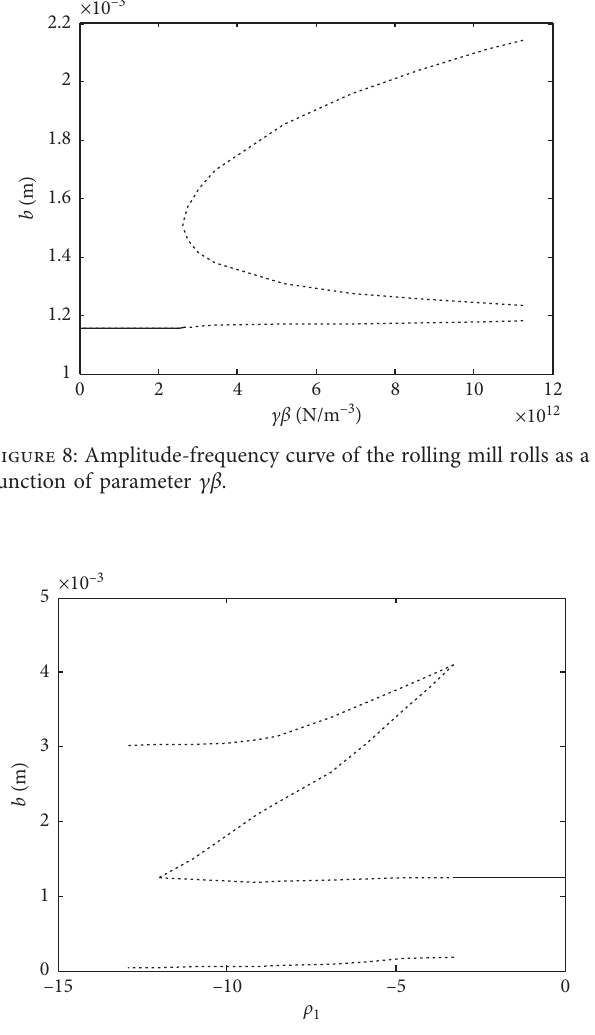
Figure 9: Amplitude-frequency curve of the rolling mill rolls as a function of coupling term parameter ρ 1 .